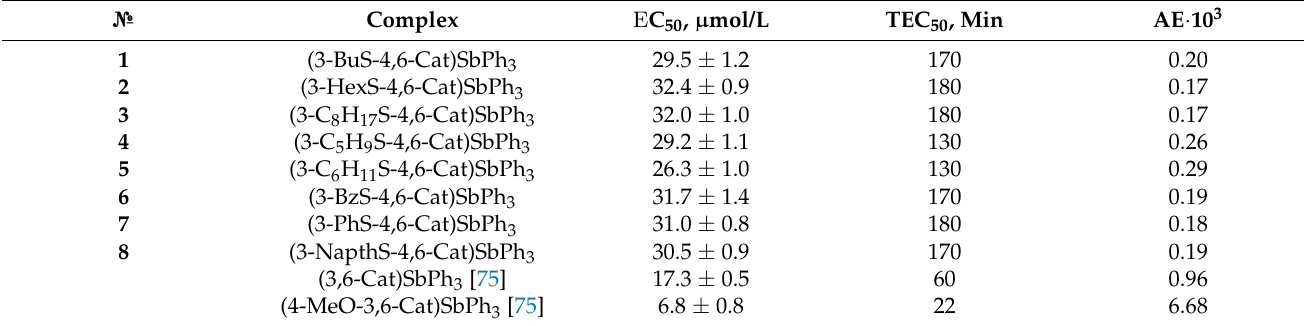
Table 3. Indicators of antiradical activity of 1 – 8 in the test with the DPPH radical (CH 2 Cl 2 , 298